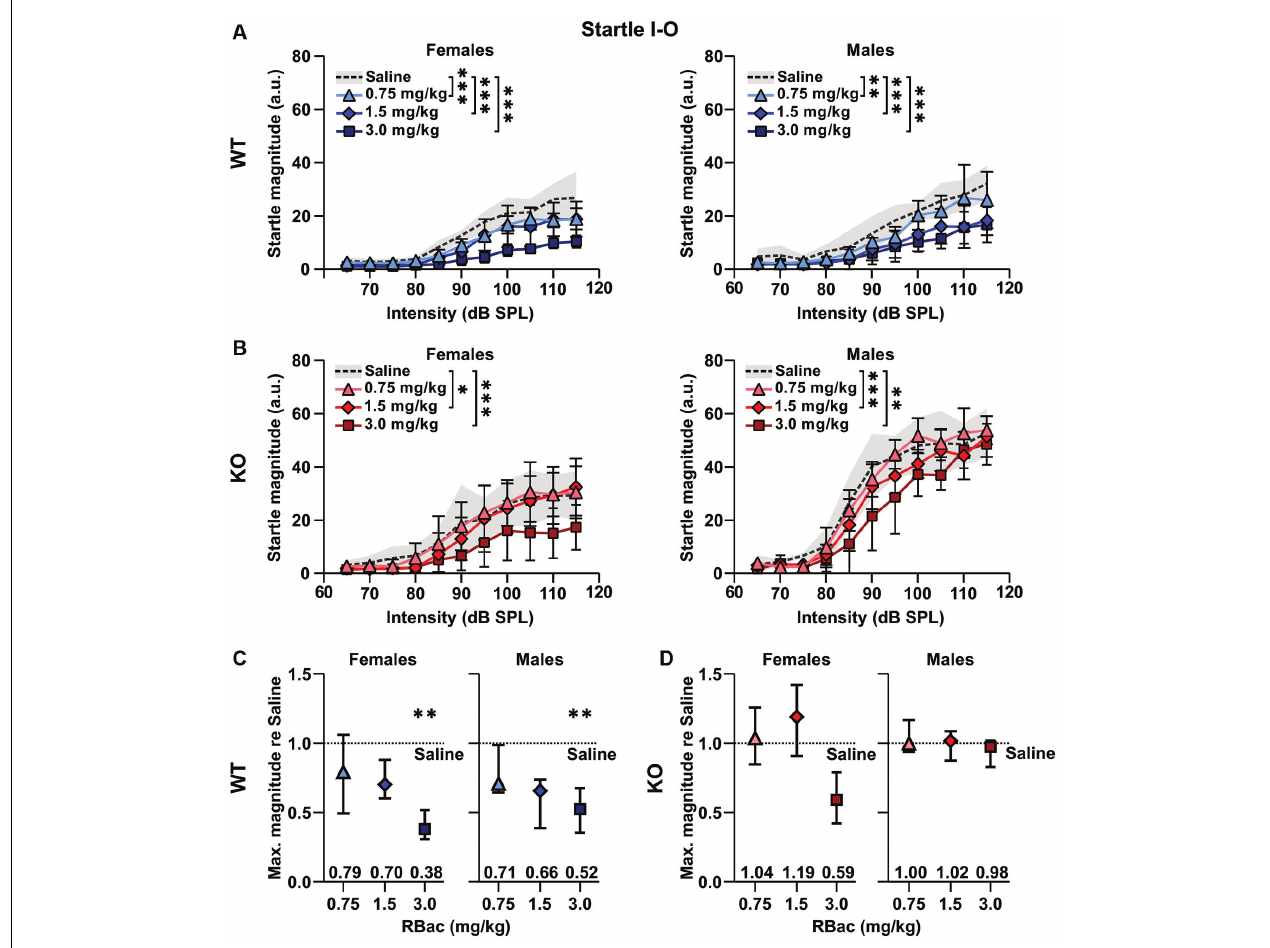
FIGURE 6 | Medium and high doses of R-Baclofen decrease ASR magnitudes in Cntnap2 KO rats to control levels. (A,B) Mean ± SD startle response magnitudes to increasing startle pulse intensities after injection of saline (dotted line and gray area), 0.75 mg/kg (triangles), 1.5 mg/kg (diamonds), 3 mg/kg R-Baclofen (squares) in Cntnap2 WT rats ( A , blue symbols) and Cntnap2 KO rats ( B , red symbols). Startle magnitudes were significantly reduced after injection of 0.75, 1.5, or 3 mg/kg R-Baclofen in comparison with injection of saline in female (A, Left) and male (A, Right) Cntnap2 WT rats ( A, Left , Cntnap2 WT F: n = 6, two-way RM ANOVA, intensity p < 0.0001, F (10,55) = 44.28, treatment p < 0.0001, F (2.453,134.9) = 86.07, intensity × treatment p < 0.0001, F (30,165) = 4.390, Dunnett’s multiple comparisons test, saline vs. 0.75 mg/kg p < 0.0001, saline vs. 1.5 mg/kg p < 0.0001, saline vs. 3 mg/kg: p < 0.0001; A, Right , Cntnap2 WT M: n = 5, two-way RM ANOVA, intensity p < 0.0001, F (10,44) = 21.39, treatment p < 0.0001, F (2.511,110.5) = 63.83, intensity × treatment p < 0.0001, F (30,132) = 2.847, Dunnett’s multiple comparisons test, saline vs. 0.75 mg/kg p = 0.0002, saline vs. 1.5 mg/kg p < 0.0001, saline vs. 3 mg/kg: p < 0.0001). (B) Startle magnitudes in female (B, Left) and male (B, Right) Cntnap2 KO rats were significantly reduced after injection of 1.5, or 3 mg/kg, but not with 0.75 mg/kg, R-Baclofen in comparison with saline injection ( B, Left , Cntnap2 KO F: n = 6, Two-way RM ANOVA, intensity p < 0.0001, F (10,55) = 17.99, treatment p < 0.0001, F (1.911,105.1) = 29.81, intensity × treatment p = 0.0405, F (30,165) = 1.568, Dunnett’s multiple comparisons test, saline vs. 0.75 mg/kg p > 0.9999, saline vs. 1.5 mg/kg p = 0.0309, saline vs. 3 mg/kg: p < 0.0001; B, Right , Cntnap2 KO M: n = 5, Two-way RM ANOVA, intensity p < 0.0001, F (10,44) = 77.47, treatment p < 0.0001, F (2.137,94.04) = 20.74, intensity × treatment p = 0.1091, F (30,132) = 1.384, Dunnett’s multiple comparisons test, saline vs. 0.75 mg/kg p = 0.9802, saline vs. 1.5 mg/kg p = 0.0003, saline vs. 3 mg/kg: p < 0.0001). (C,D) Comparison of ASR maximum response. (C) In both female ( Left ) and male ( Right ) Cntnap2 WT rats, R-Baclofen induced a significant decrease in the maximum ASR capacity at 115 dB SPL (WT F: Friedman test, p = 0.0085, Dunn’s multiple comparisons test, 0.75 mg/kg p > 0.9999, 1.5 mg/kg p = 0.5391, 3.0 mg/kg p = 0.0052; WT M: Friedman test, p = 0.0120, Dunn’s multiple comparisons test, 0.75 mg/kg p = 0.6620, 1.5 mg/kg p = 0.0825, 3.0 mg/kg p = 0.0099). (D) R-Baclofen did not induce a decrease in maximum ASR capacity from female ( Left ) nor male ( Right ) Cntnap2 KO rats (KO F: Friedman test, p = 0.1268; KO M: Friedman test, p = 0.3720). ∗ p < 0.05; ∗∗ p < 0.01; ∗∗∗ p < 0.001.